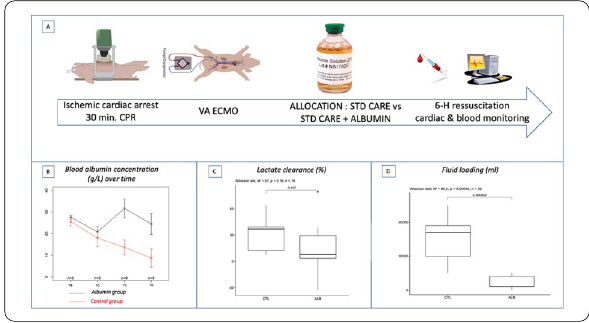
Panel A: experimental protocol. Panel B: albumin concentration over time (in hours). Panel C: Lactate clearance 6 h after initial resuscitation. Panel D: fluid loading over a 6 h resuscitation. ALB: albumin group. CTL: control